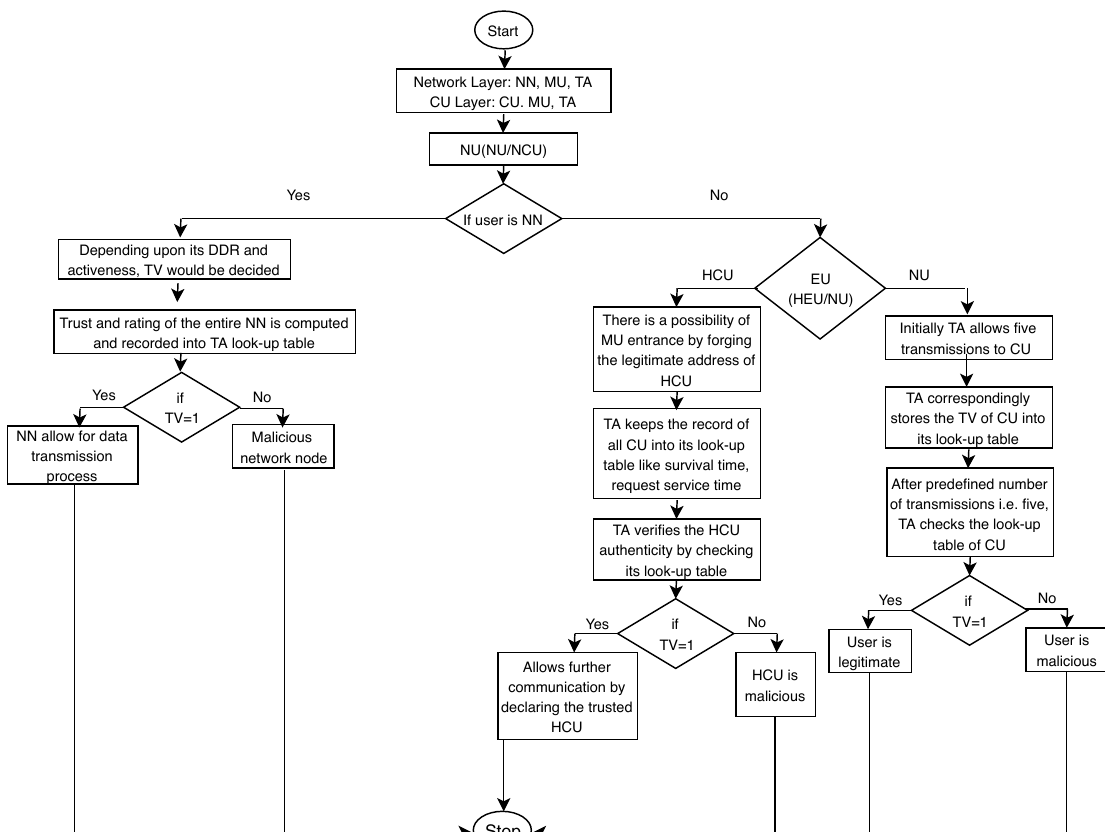
Figure 3. Proposed framework at the network